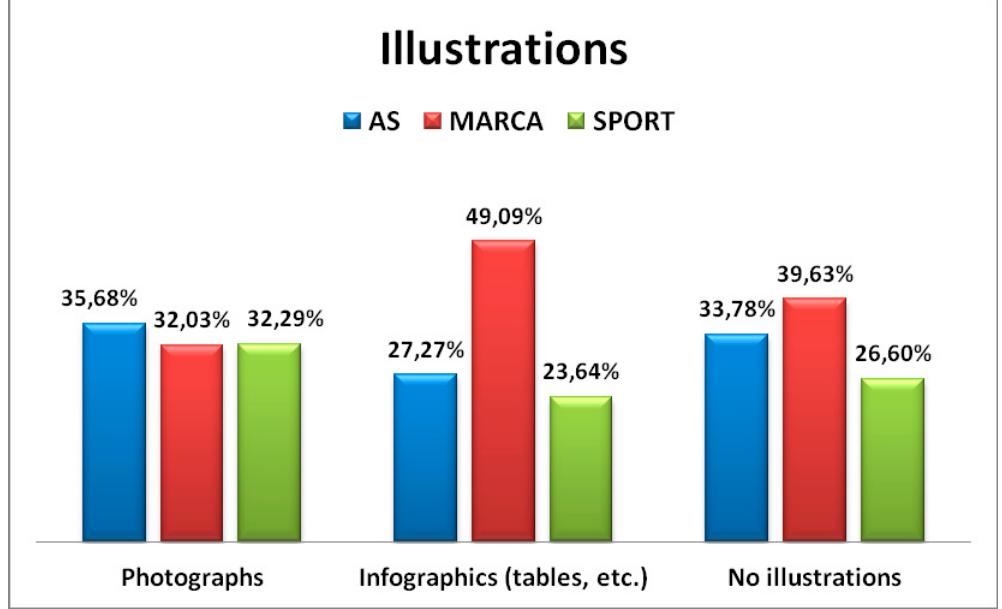
Figure 2. Illustrations included in health content units.